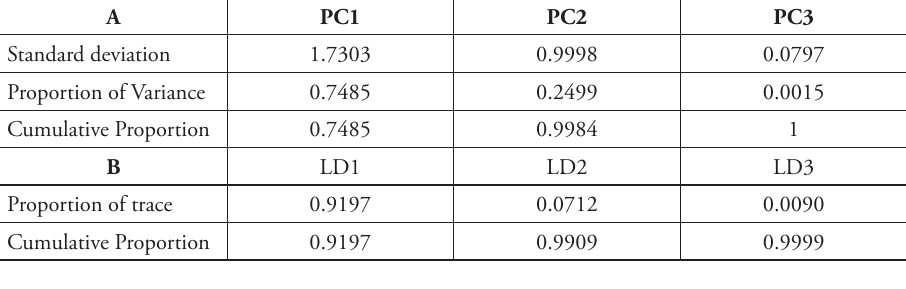
Table 1. Summary of the results of the first 3 principal components (PC) and linear discriminants (LD) of principal component analysis and linear discriminant analysis, respectively.